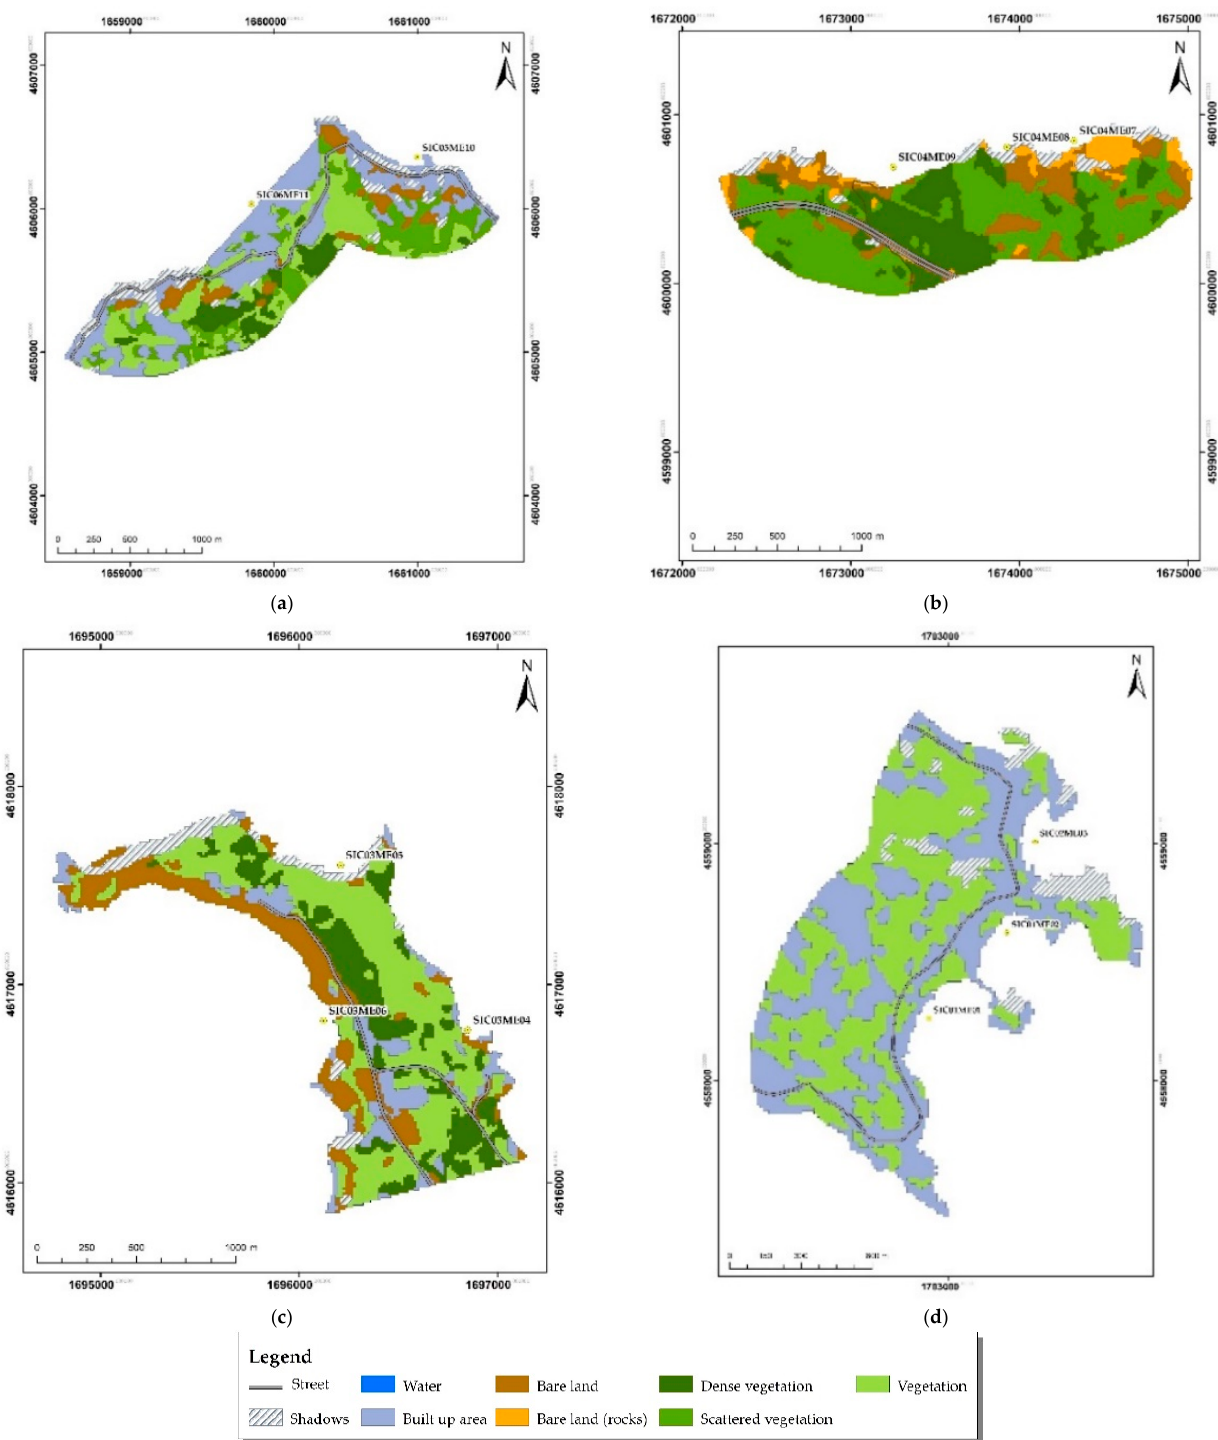
Figure 4. Land use/land cover classification results for the PBs of Sicily, the main island, clockwise from top left: East Capo Calavà (SIC05ME10) and West Capo Calavà (SIC06ME11) ( a ); Patt–Tindari’s PBs East (SIC04ME07), Center (SIC04ME08), and West (SIC04ME09) ( b ); Milazzo’s PBs East (SIC03ME04), North (SIC03ME05), and West (SIC03ME06) ( c ); South Isola Bella (SIC01ME01), North Isola Bella (SIC01ME02), and Mazzarò (SIC02ME03) ( d ).